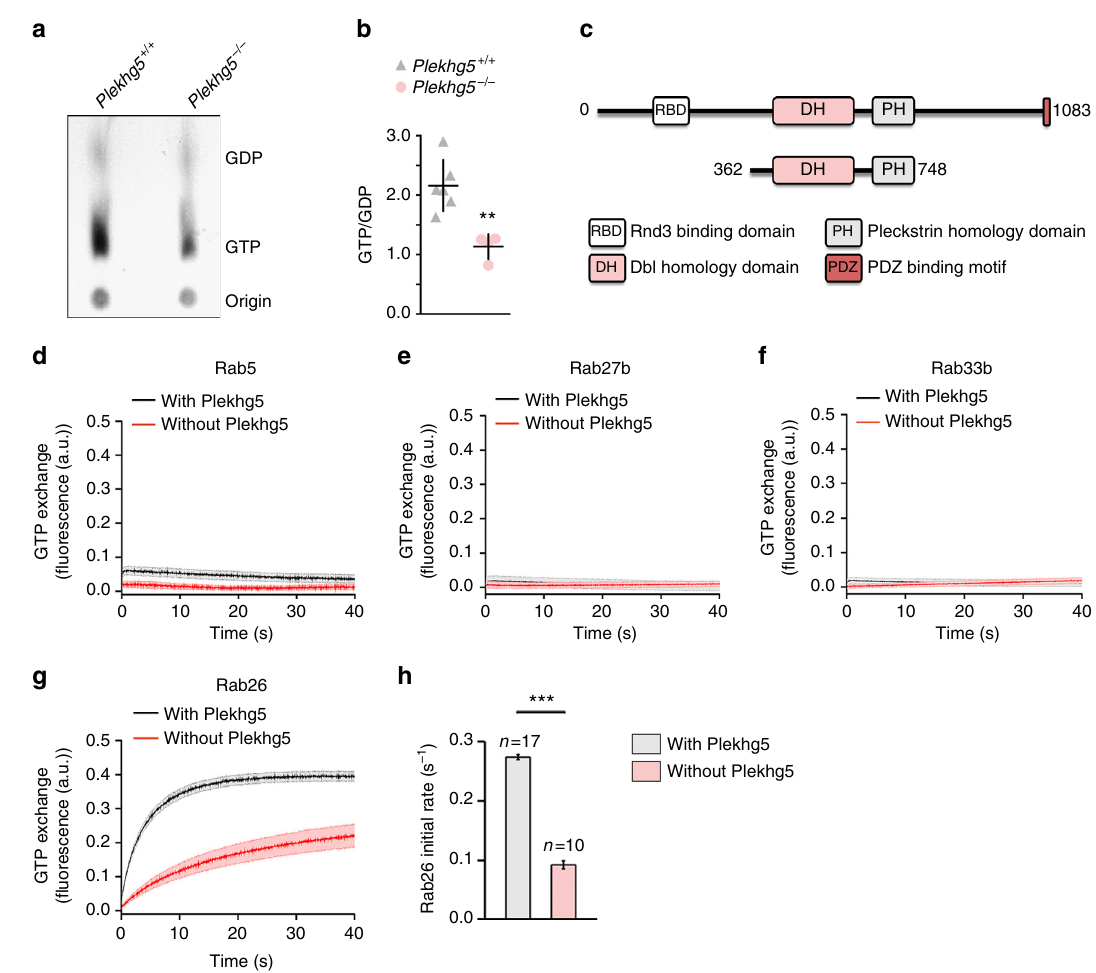
Fig. 7 Plekhg5 functions as a GEF for Rab26. a Neurosphere-derived cortical neurons were transduced with EGFP-Rab26 and labeled with P 32 for 4 h. EGFP-Rab26 was immunoprecipitated and GTP- or GDP-bound Rab26 was separated by TLC. b Densitometric quanti fi cation of GTP/GDP ratios (each data point represents one independent experiment. Mean ± SEM; unpaired t -test; two-tailed). c – h Exchange activity of Plekhg5 on different GTPases. c Scheme of the DH-PH tandem domain, which was puri fi ed and used for the biochemical assays. Exchange activity of Plekhg5 on Rab5 d , Rab27b e , Rab33b f , and Rab26 g was measured by monitoring the fl uorescent increase of Mant-GppNHp upon binding to Rab proteins. g The initial GTP exchange rate of Rab26 was evaluated using the fi rst 10 s of each time course. (Mean ± SEM; Student ʼ s t -test;